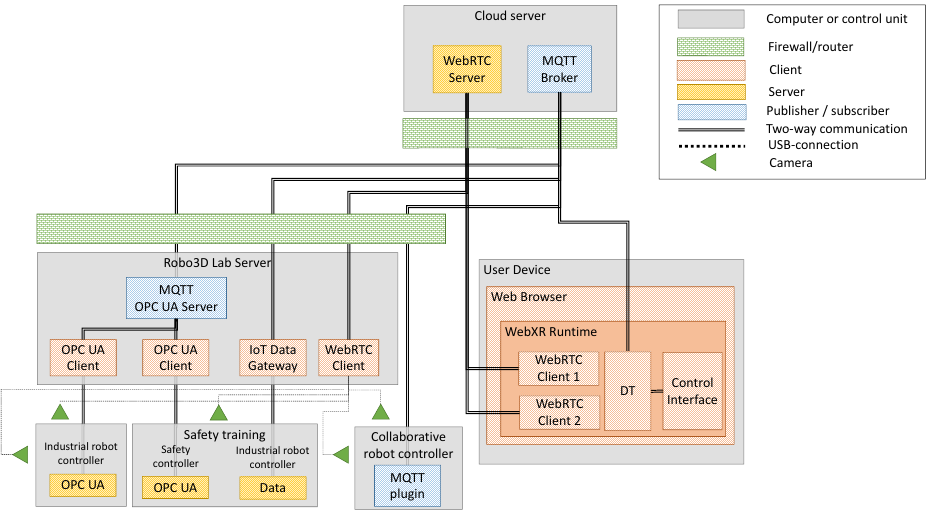
Figure 4. System